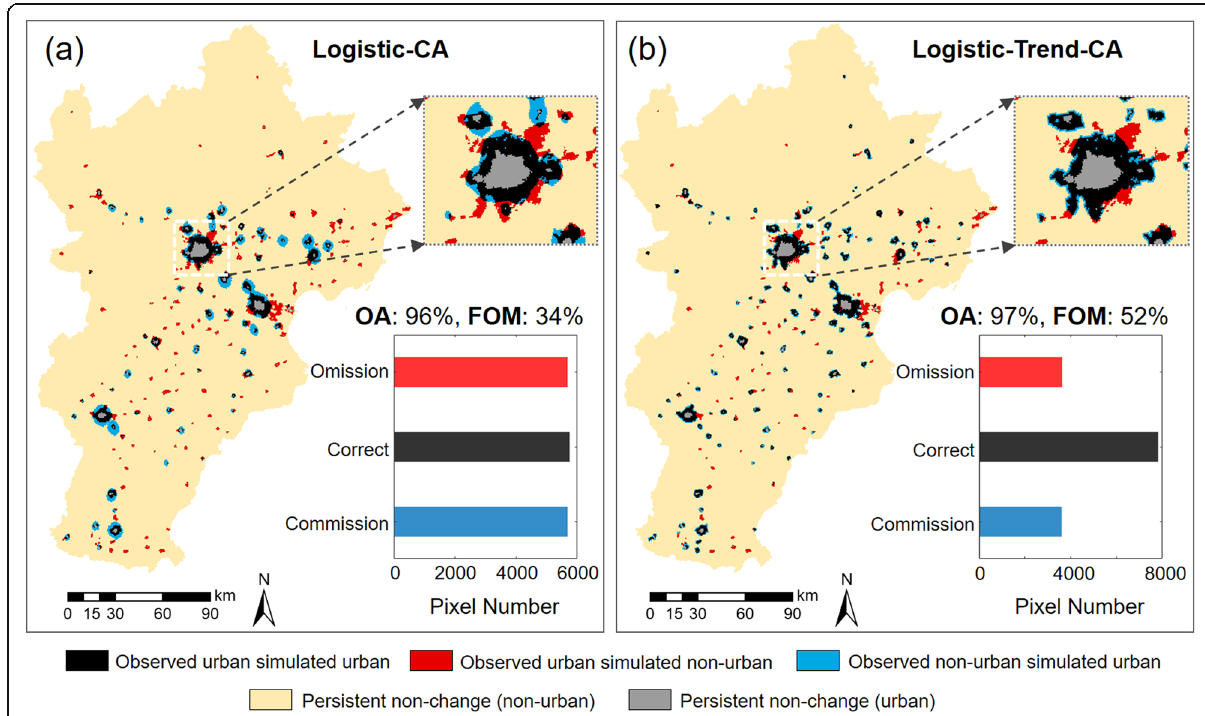
Fig. 5 Comparison of the urban sprawl modeling during 1992 – 2013 using the traditional Logistic-CA ( a ) and the Logistic-Trend-CA ( b ) in the Beijing-Tianjin-Hebei region at the 1-km spatial